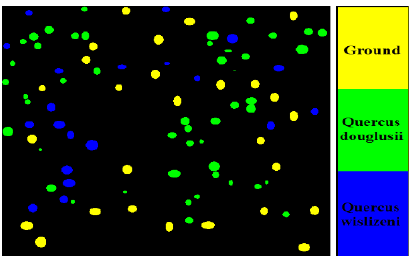
Figure 2. The GT used in the study for